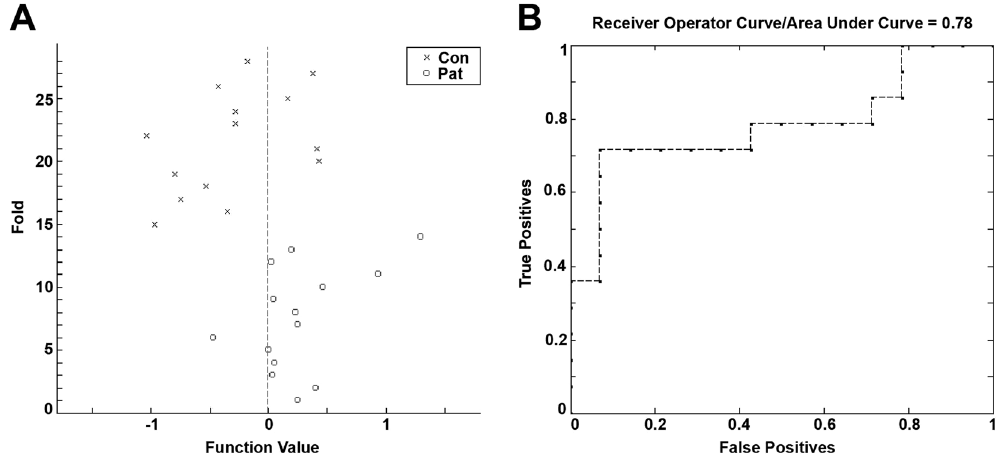
Figure 2. Prediction values ( A ) and the Receiver Operating Characteristic (ROC) curve ( B ) of group classification based on FA (averaged across all